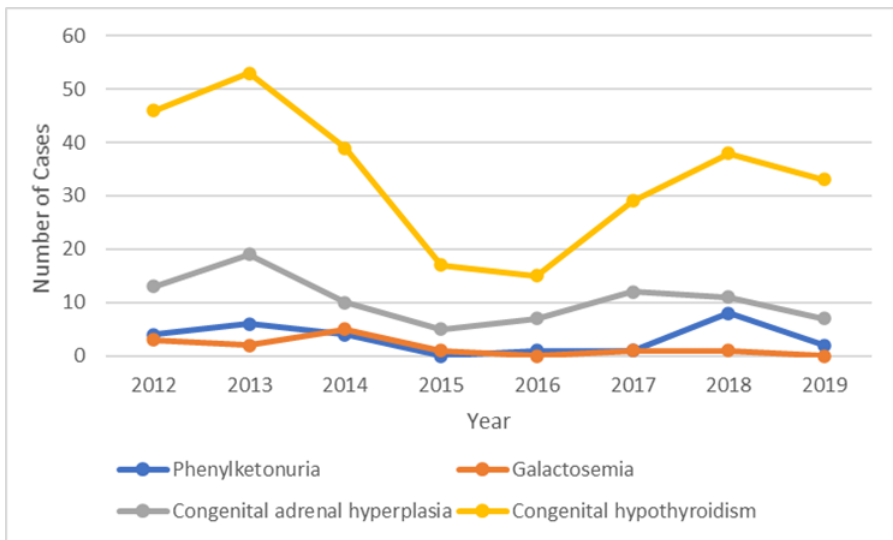
Figure 2. Cases diagnosed by the NBS Program distributed by years in Ecuador, 2012–2019.